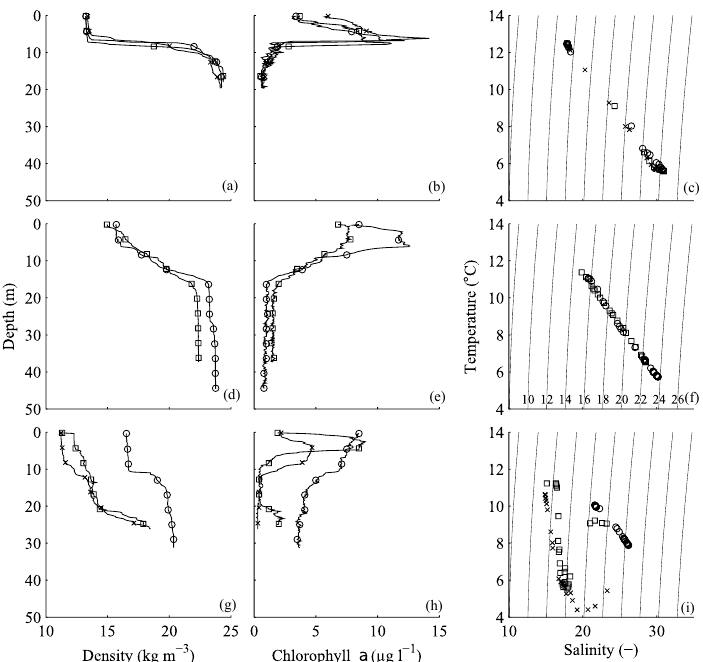
Figure 8. Vertical profiles of density (a, d, g) and chlorophyll a (b, e, h) , and the corresponding distributions of temperature and salin- ity (in Practical Salinity Units) (c, f, i) . In the salinity–temperature plots the lines are contours of constant density (minus 1000kgm − 3 ). The observations were made on 18 May 2004 between 08:19 and 09:16UTC at stations 14 (circles), 16 (squares), and 18 (crosses), all shown in (a) – (c) , on 18 May 09:34 at Station 51 (circles) and on 19 May 05:26 at Station 20 (squares), shown in (d) – (f) , and on 19 May between 05:52 and 08:41 at stations 21 (circles), 27 (squares), and 29 (crosses), shown in (g) – (i)